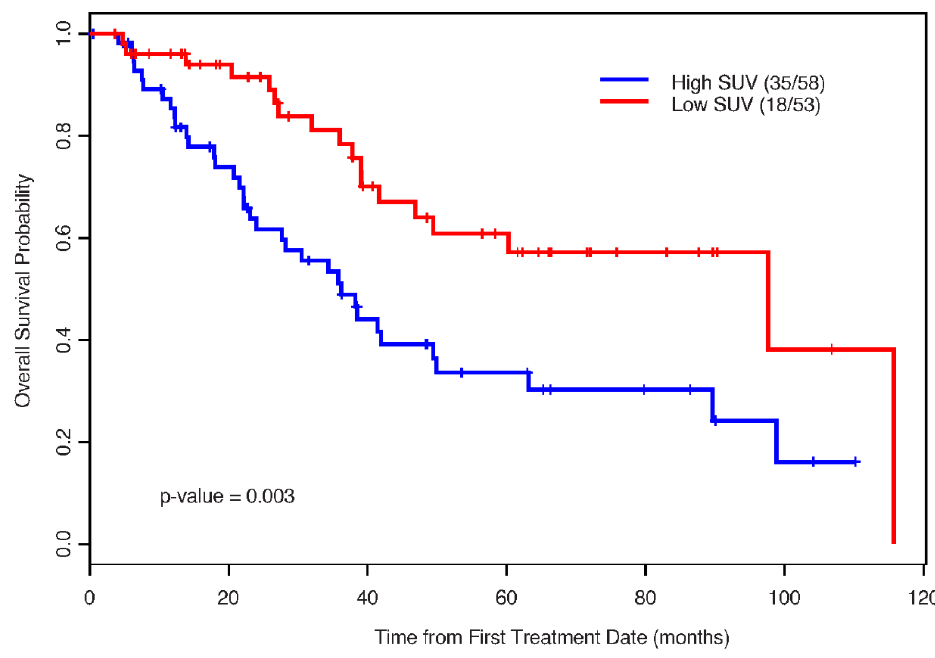
Figure 4. The Kaplan–Meier estimates for overall survival by SUV status.